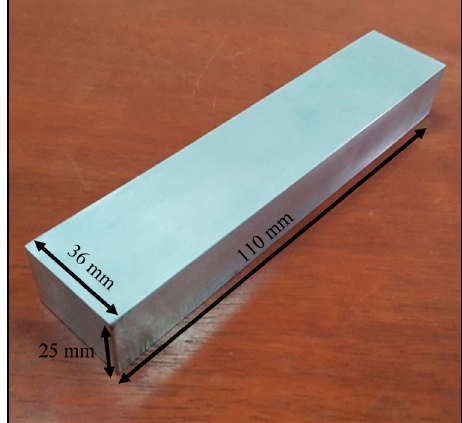
Figure 1. Recycled AA 6063.